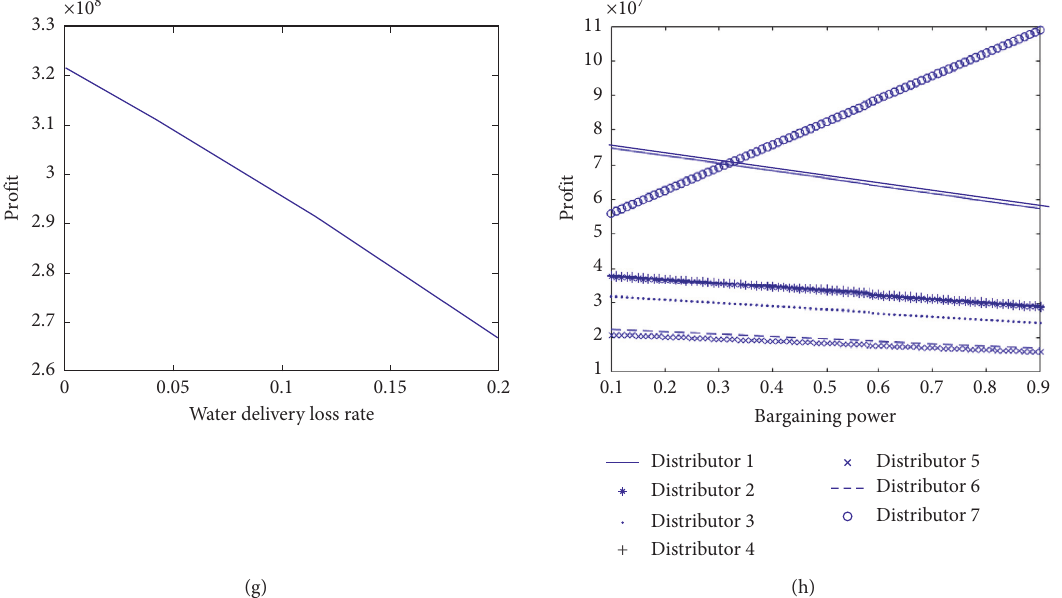
Figure 2: The impact of key parameters’ change on the profit of the IBWTsupply chain with partial backlogging. (a) Mainline transfer cost; (b) branch-line transfer cost; (c) holding cost; (d) shortage cost; (e) backlogging ratio; (f) price elasticity; (g) water delivery loss rate; (h) bargaining